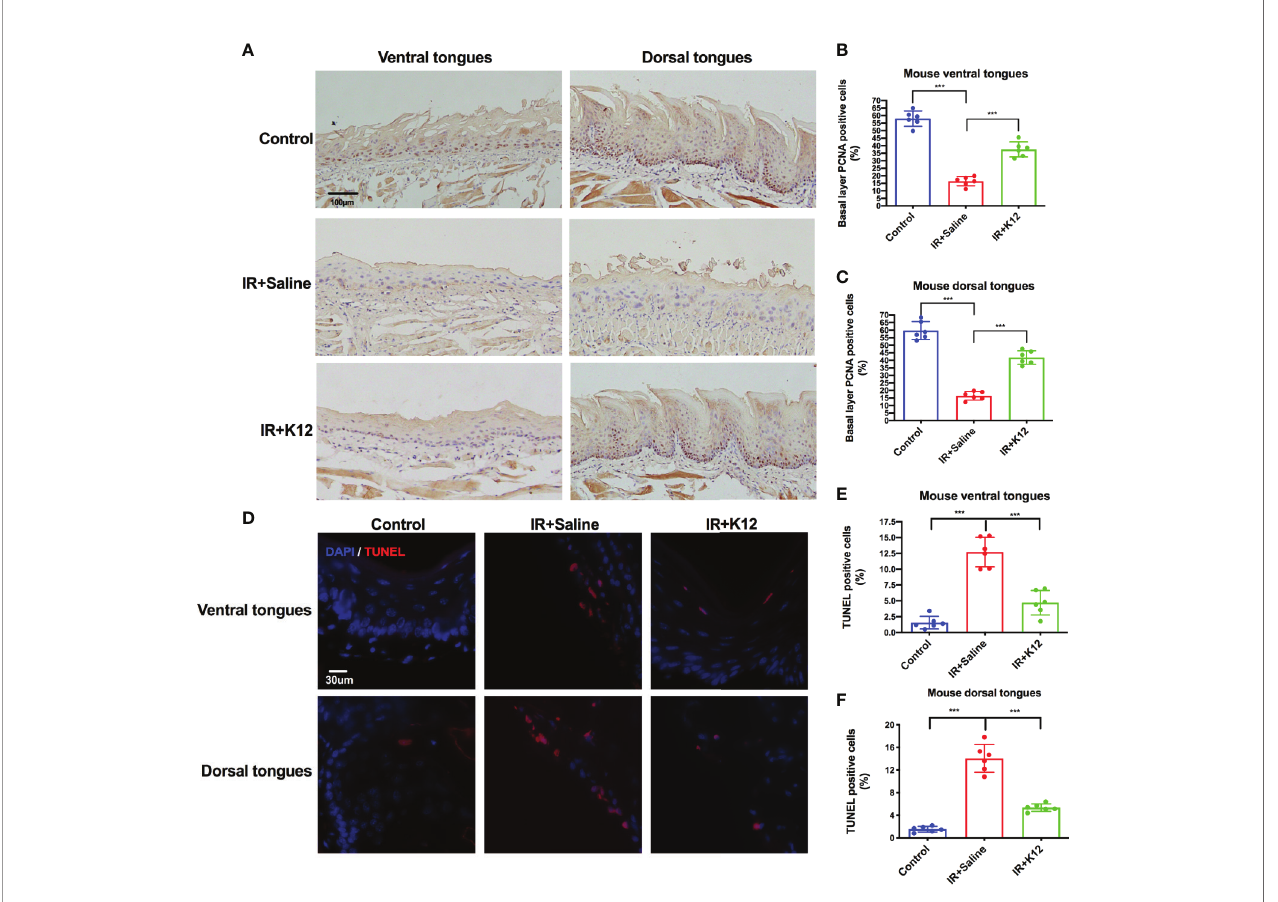
FIGURE 3 | Streptococcus salivarius K12 promoted the proliferation of mouse tongue basal layer cells and reduced apoptosis of mouse tongue mucosal cells. (A) Representative microscopic images of mouse tongues PCNA staining (Scale bar, 100 µm). (B) Percentage of basal layer PCNA positive cells in mouse ventral tongues. (C) Percentage of basal layer PCNA positive cells in mouse dorsal tongues. (D) Representative microscopic images of TUNEL staining on mouse tongues (Scale bar, 30 µm). (E) Percentage of TUNEL-positive cells in mouse ventral tongues. (F) Percentage of TUNEL-positive cells in mouse dorsal tongues. Data are presented as mean ± SD. N=6 per group. One-way ANOVA test followed by Tukey ’ s test. *** P <